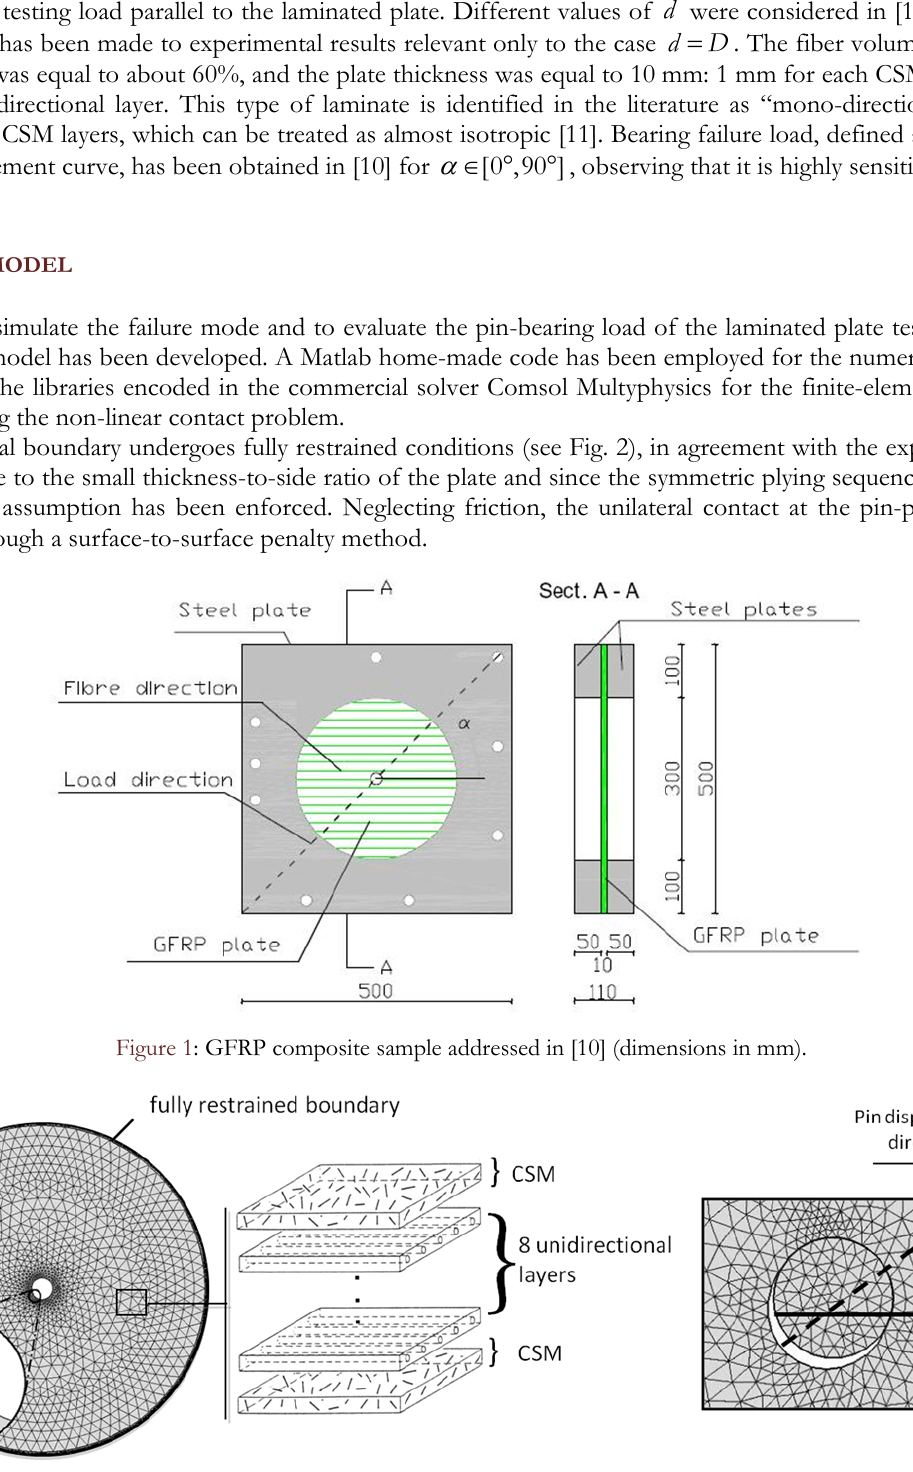
Figure 2: Mesh details, loading conditions and laminate plying pattern employed for numerical simulations (on the left, pin is not